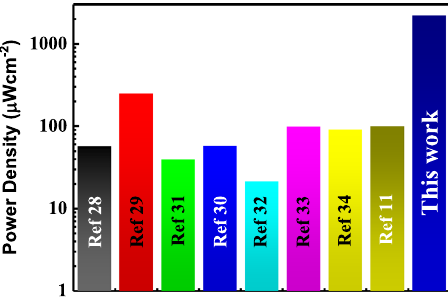
Fig. 7 Power density comparison across literatures for thin- fi lm organic and organic-inorganic hybrid based TEG modules. The power density of the transparent fl exible thin- fi lm p - n junction TE module in this work shows almost an order of magnitude higher than those of other organic-basedand hybrid-based thermoelectric generator (TEG)